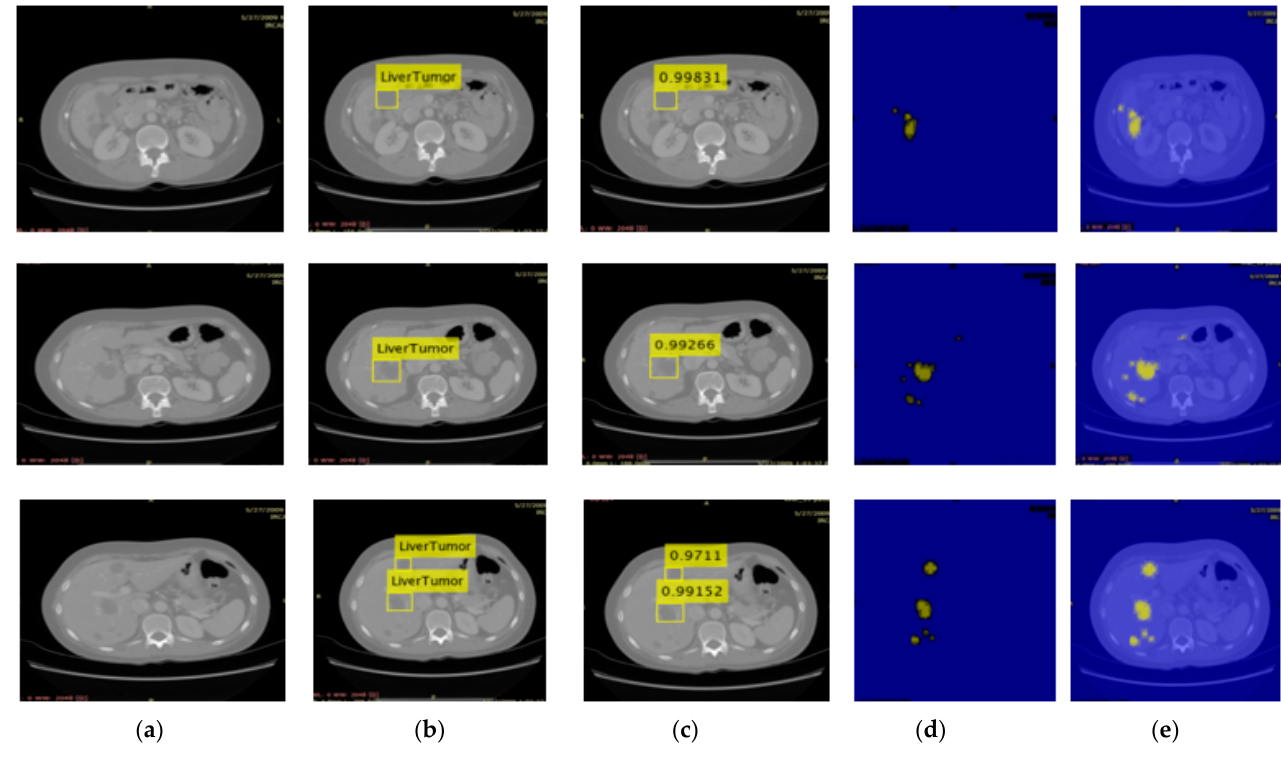
Figure 13. Liver tumor segmentation ( a ) input liver CT ( b , c ) localization ( d ) 3D-segmentation ( e ) mapping on liver CT.